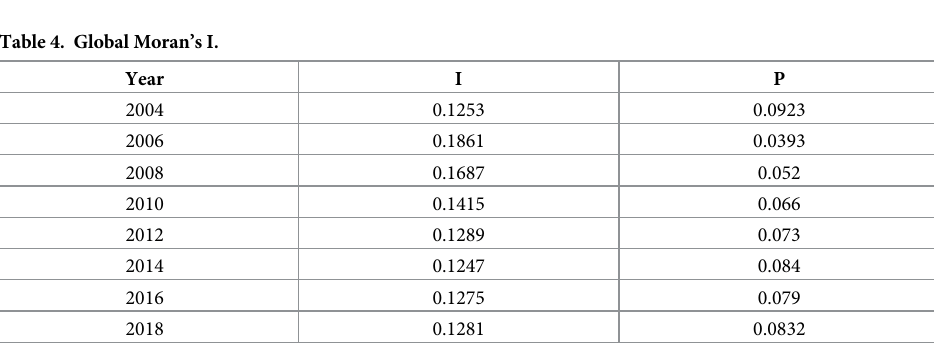
Table 4. Global Moran’s